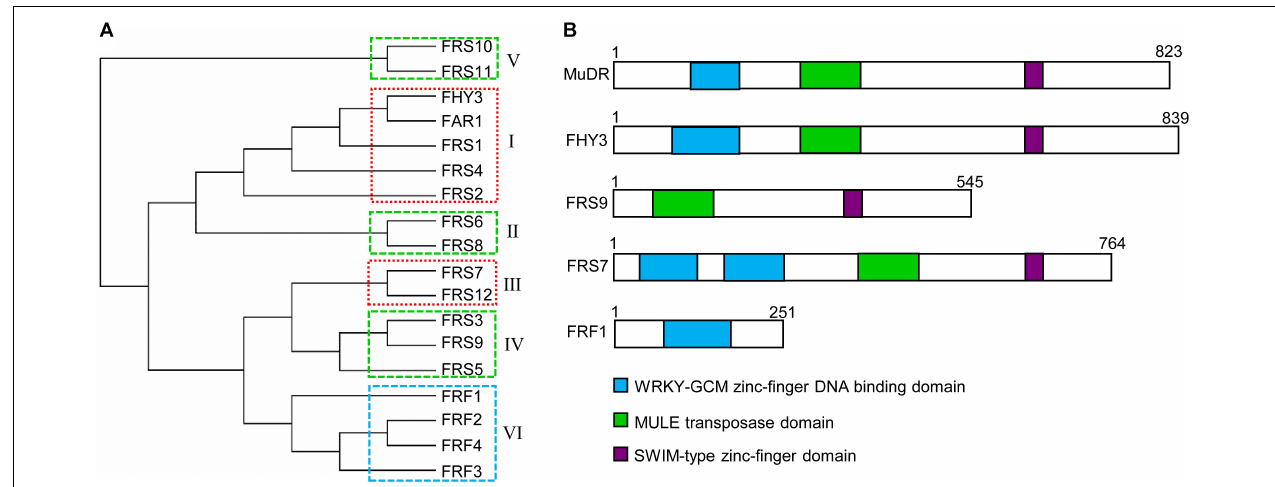
FIGURE 1 | Phylogenetic and protein domain structures of the FRS-FRF family in Arabidopsis . (A) Multiple alignment of FRS and FRF family proteins were performed using MAFFT (V6.864, http://www.genome.jp/tools-bin/mafft). Phylogenetic analysis was generated using the neighbor-joining method (PHYLYP, V3.66) and displayed with MEGA (v7.0). FRS-FRF family proteins were classified into six subgroups (I–VI) based on their protein structures. The boxes with dashed lines indicate FRS-FRF members in the same clade that might form homodimers or heterodimers to coordinately regulate the transcription of their target genes. (B) The conserved protein domains in select FRS-FRF family proteins are